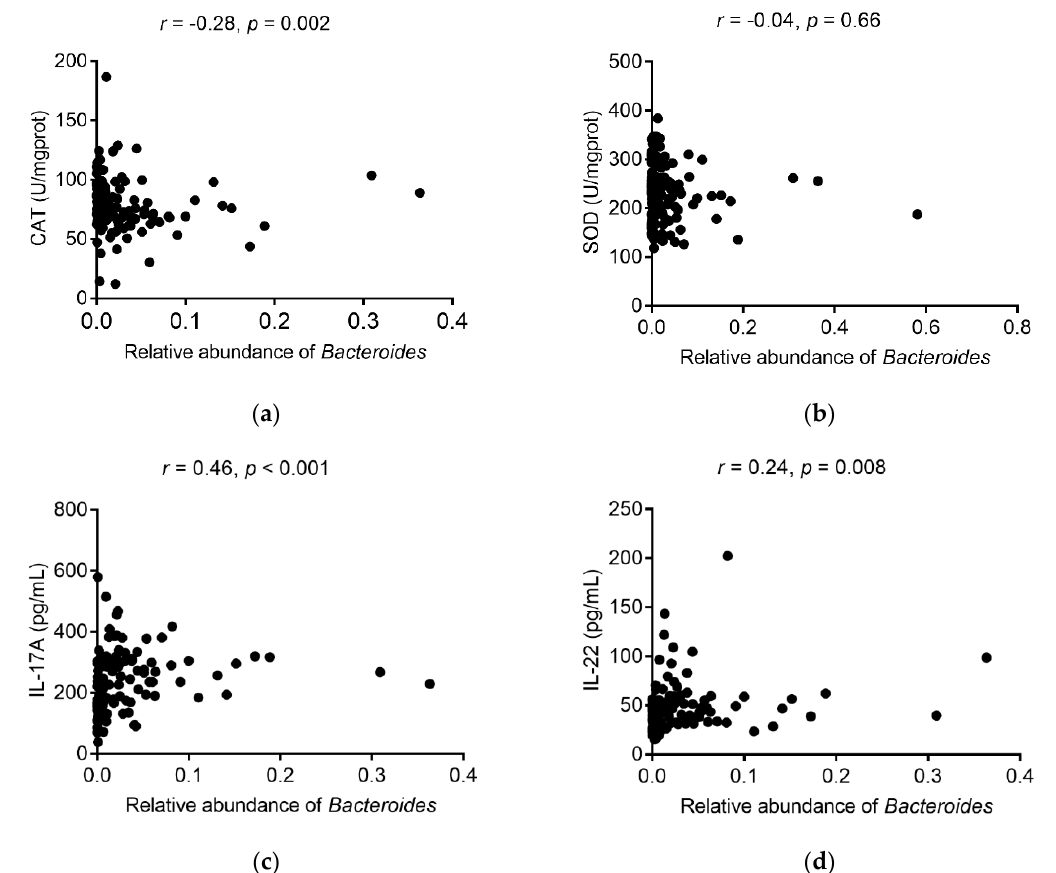
Figure 6. Correlation between Bacteroides and inflammation and oxidative indicators. ( a ) Correlation between Bacteroides and CAT; ( b ) Correlation between Bacteroides and SOD; ( c ) Correlation between Bacteroides and IL-17A; ( d ) Correlation between Bacteroides and IL-22. Spearman’s correlation analysis was used to analyze the relationship.